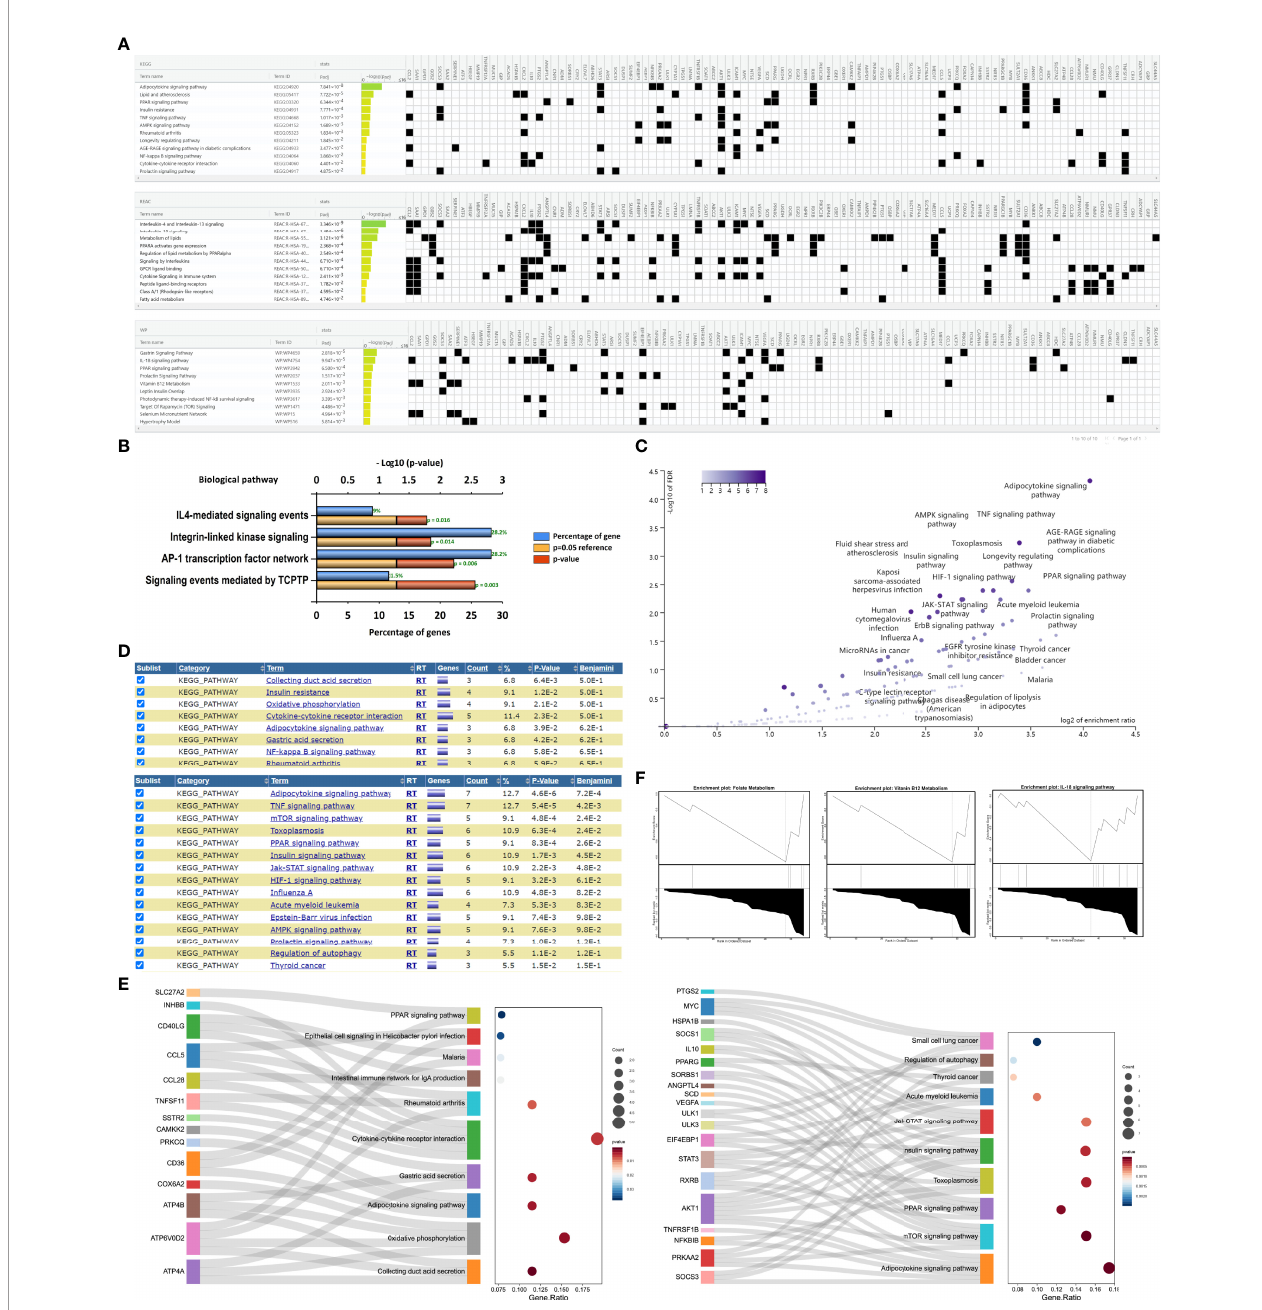
FIGURE 3 | Pathway enrichment analyses of ORDEGs between OLF and control samples. (A) Pro fi ler analysis showed the top 10 signi fi cant KEGG pathways, REAC pathways, and WP WikiPathways. (B) Funrich analysis indicated the 4 signi fi cant biological pathways. (C) Over-representation analysis of WebGestalt showed enrichment pathways of down-regulated genes, but no enriched results of up-regulated genes. (D) DIVID analysis showed enrichment pathways of down-regulated genes and up-regulated genes. (E) KEGG histogram plot showed the enriched pathways of up-regulated genes and down-regulated genes. (F) GSEA analysis showed signi fi cant enrichment pathways were involved in folate metabolism, vitamin 12 metabolism, and IL-18 signaling pathway in WP